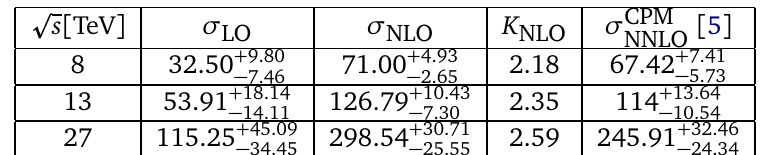
Table 2: Predictions for p + p → γγγ + X total cross section at the different center- (cid:112) s . Numerical error of calculation is equal of-mass energies,